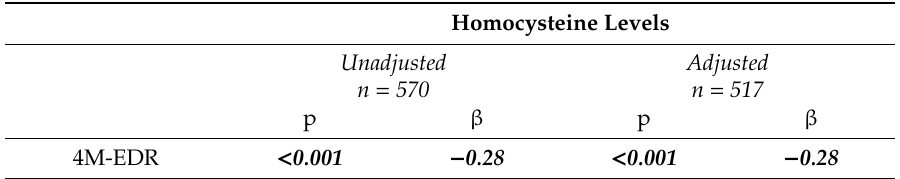
Table 5. Associations between 4M-EDR and homocysteine levels, with and without adjustments for homocysteine determinants. Homocysteine Levels Unadjusted Adjusted n = 570 n = 517 p β p β 4M-EDR